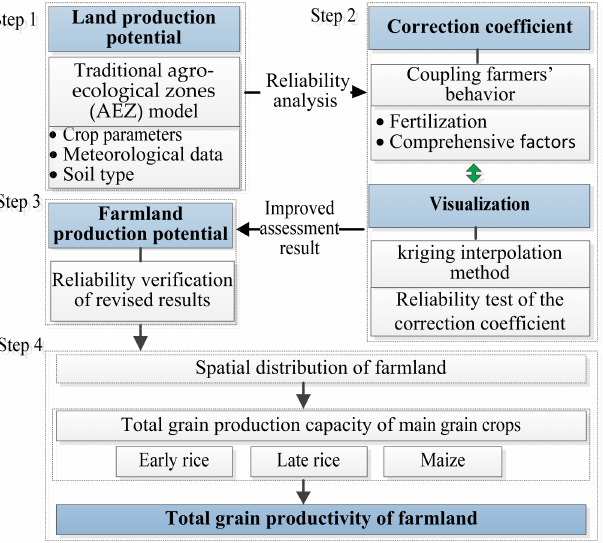
Figure 2. The research framework for assessing farmland grain productivity coupled with farmers’ behaviors. The arrow shows the logical nexus between the